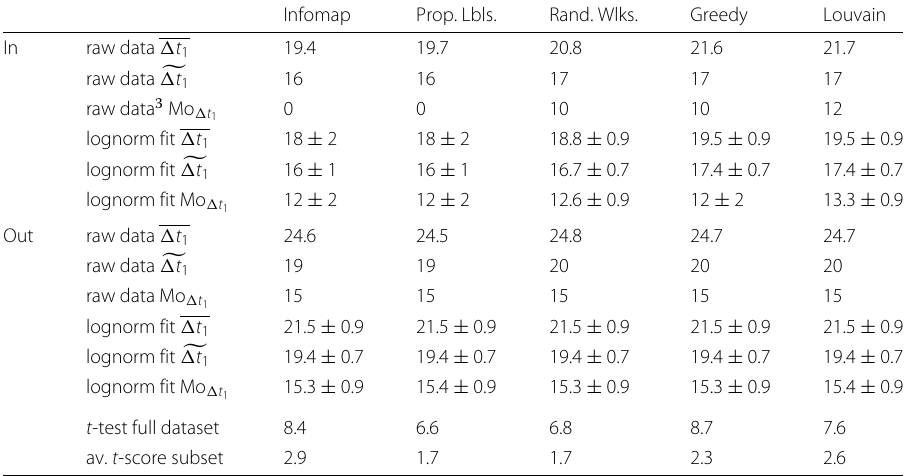
Table 4 Community-related differences in the time lag (cid:4) t 1 until first citation Infomap Prop. Lbls. Rand. Wlks. Greedy Louvain raw data (cid:4) t